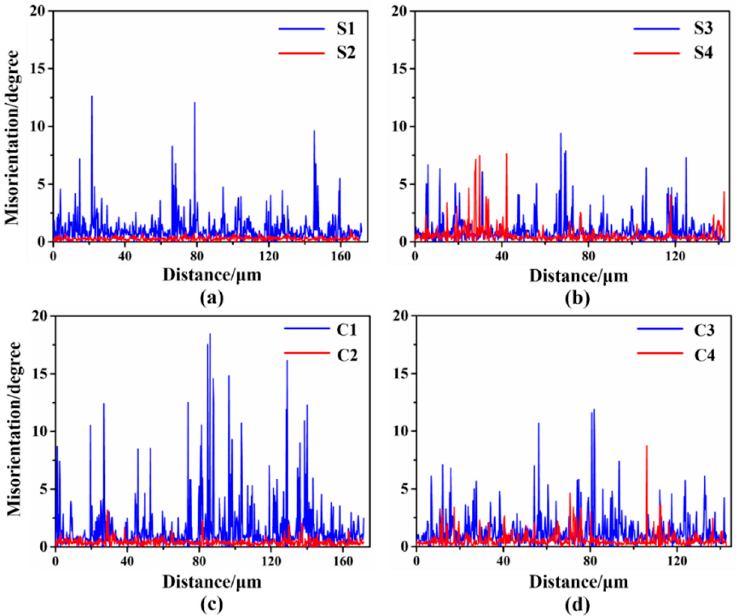
Figure 4. Misorientation maps along the scanning lines ‘S1’ to ‘S4’ and ‘C1’, ‘C2’, to ‘C4’, as shown in Figure 3. UR: ( a ) surface region and ( c ) center region, CR: ( b ) surface region and ( d ) center region.